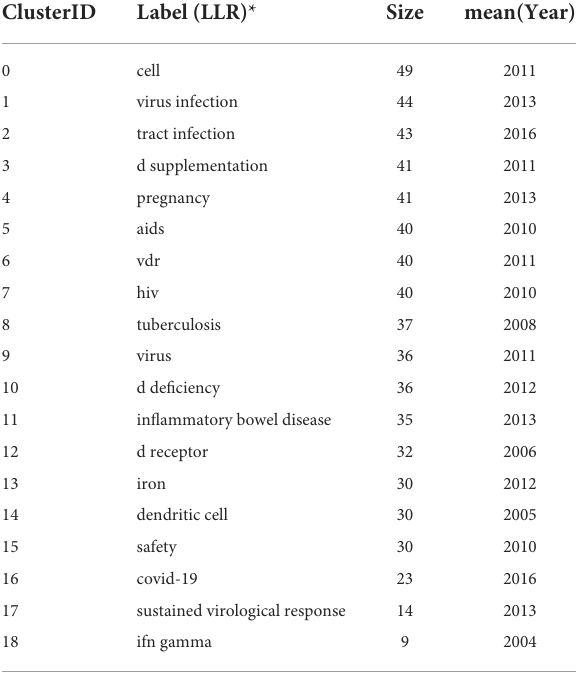
TABLE 4 Cluster summary (19 clusters by size,